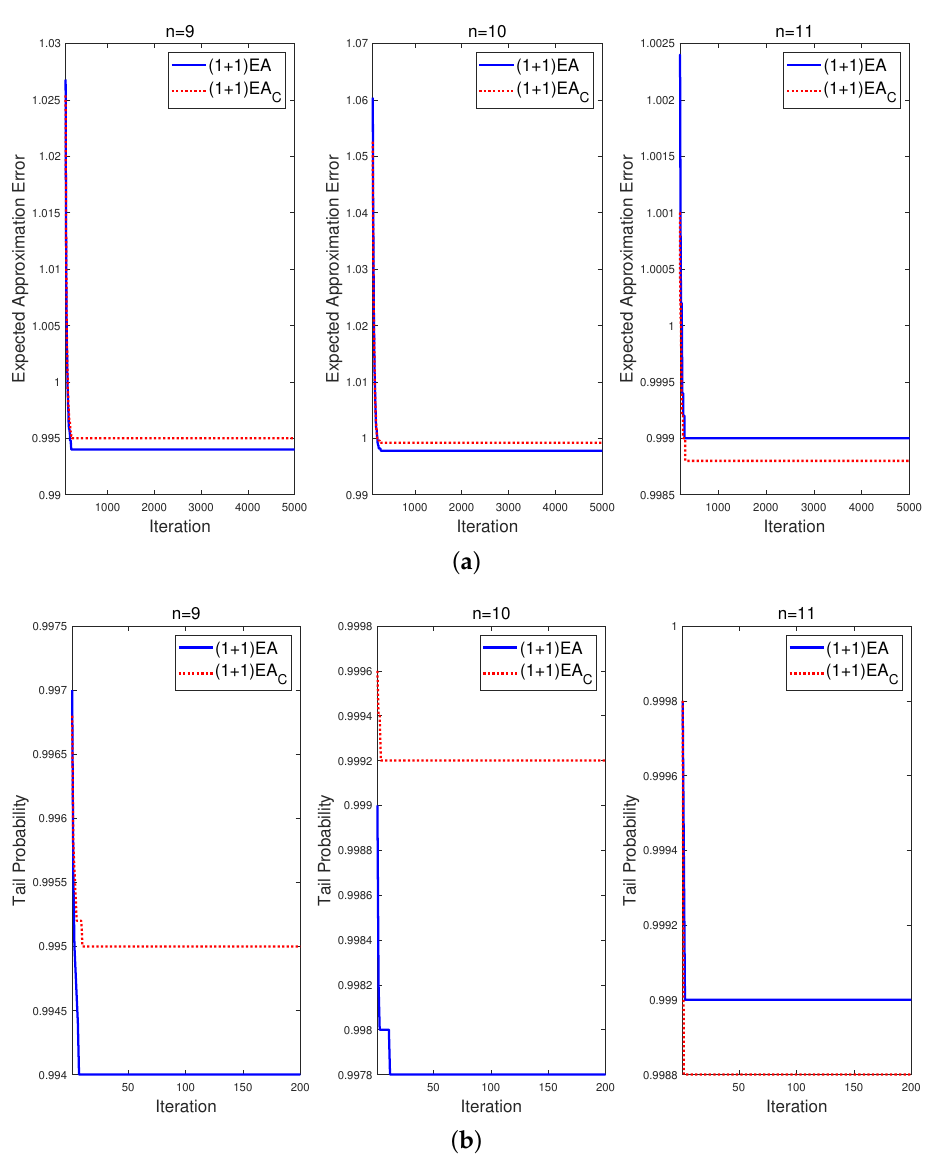
Figure 2. Numerical comparison for ( 1 + 1 ) EA and ( 1 + 1 ) EA C applied to the Deceptive problem, where n refers to the problem dimension. ( a ) Numerical comparison of expected approximation errors (EAEs). ( b ) Numerical comparison of tail probabilities